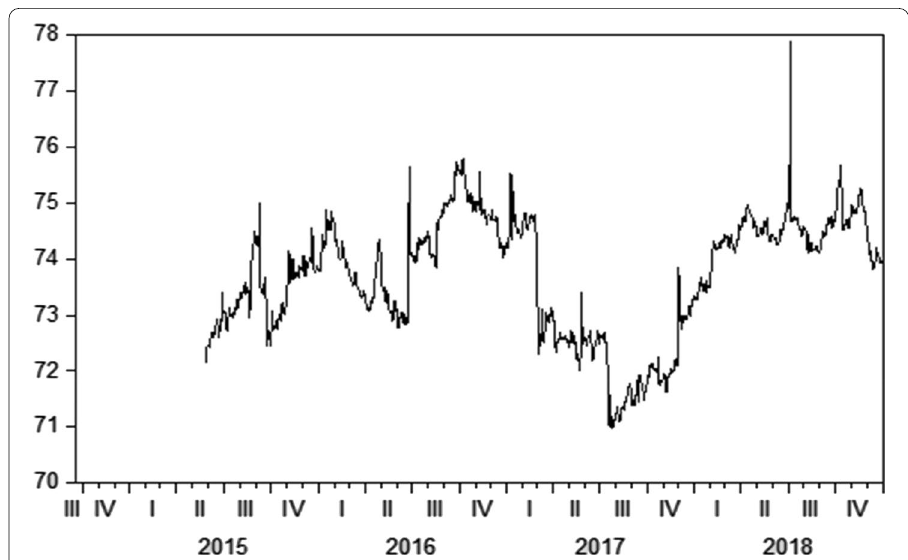
Fig. 7 Average volatility spillover (250 days rolling window) for the 2N-dimensional VAR model with positive and negative volatilities—Bitcoin markets and foreign exchange pairs of major trading currencies. The Y-axis depicts the volatility spillover values and the X-axis depicts the time period